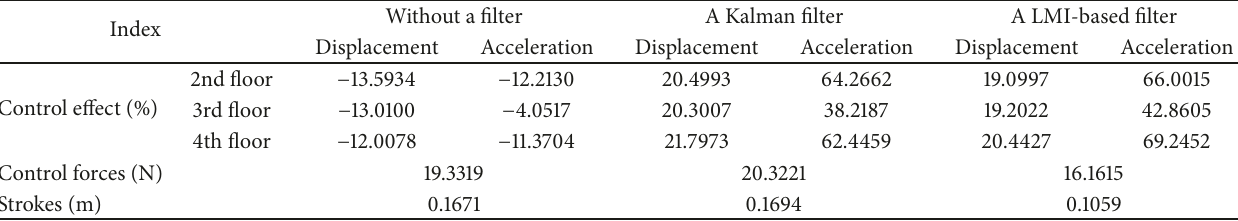
Table 6: Control effectiveness of structural